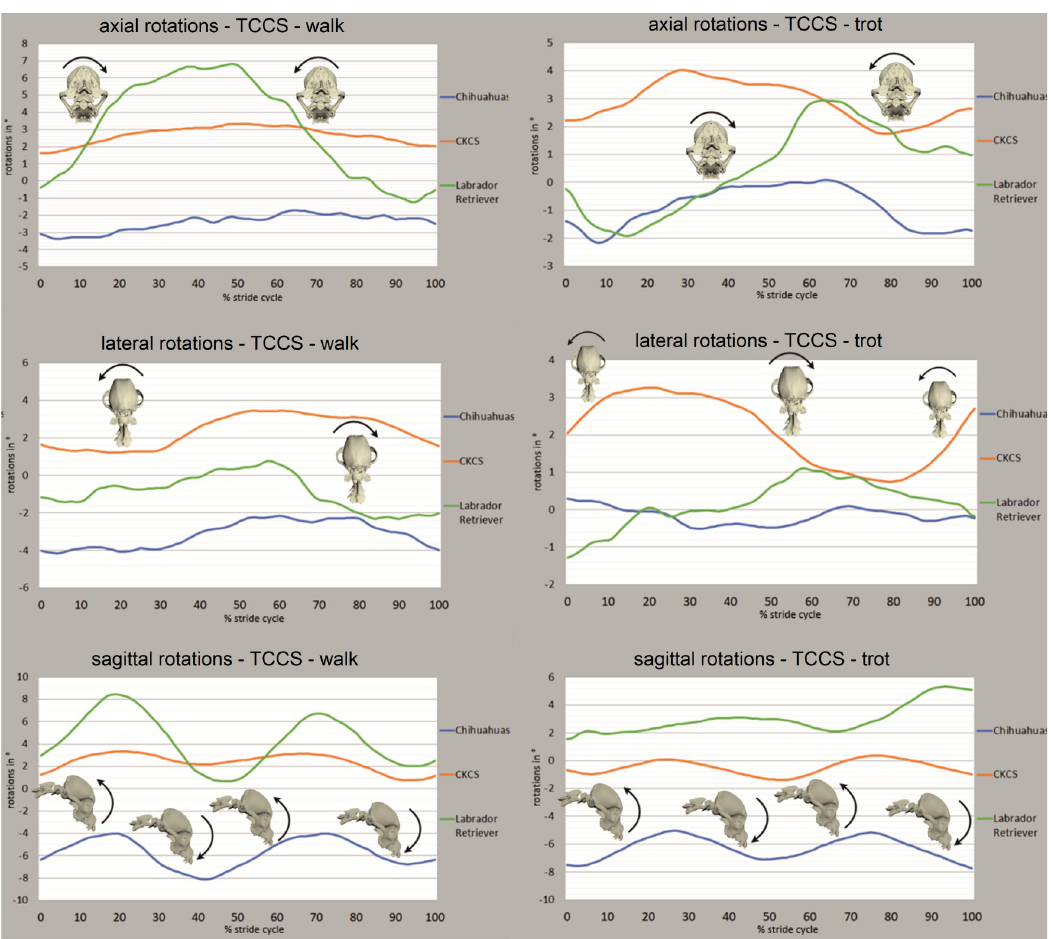
Fig 6. Phase-normalised rotational movements of the total cranial cervical spine (TCCS) in walk and trot. All rotational degrees of freedom as mean values for all strides of Chihuahuas (blue), CKCSs (orange) and Labrador retrievers (green) are depicted. X-axis represents one complete stride cycle from touchdown (0%) to subsequent touchdown (100%) of the left hind limb. Y-axis represents the motion amplitude in degrees. Bone models and arrows indicate direction of stride cycle-dependent bone movement.